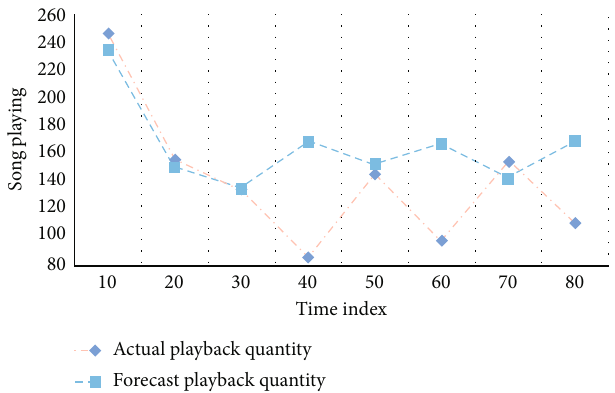
Figure 4: Comparison between predicted playback volume and actual playback volume of singer songs.